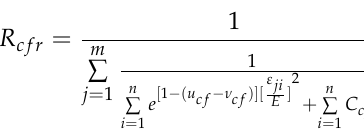
Figure 4. Resistance relationship of the embedded CFRP.